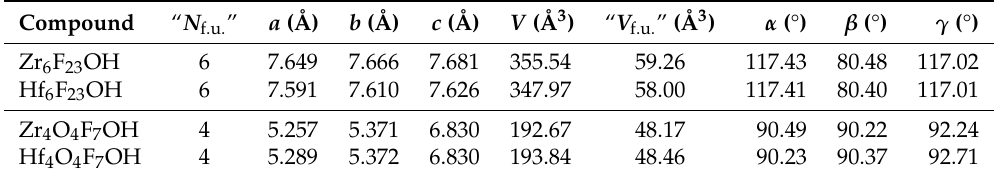
Table 3. Relaxed unit cell parameters for the mono-hydroxylated products. Given are the number of pseudo-formula units per unit cell when not differentiating between F and OH (“ N f.u. ”), unit cell vectors ( a , b , c ), unit cell volume ( V ), unit cell volume per pseudo-formula unit (“ V f.u. ”), and the non-orthogonal angles ( β ); note that all structures possess P1 symmetry. Compound “ N f.u. ”